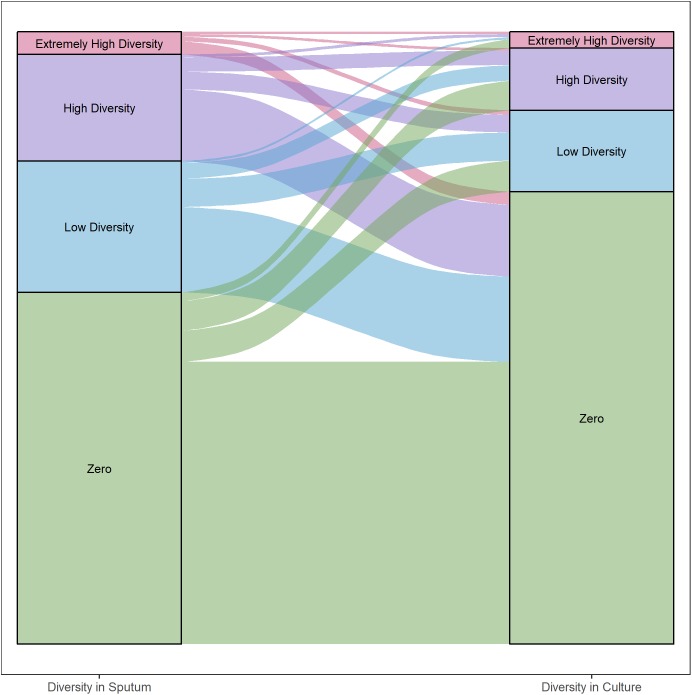
Differences in gene diversity of sputum and culture samples. Alluvial plot of changes in nucleotide diversity (π) per gene in sputum and culture samples (left and right, respectively). Inter- and intra-patient samples were all included. Categories defined by diversity quartiles: Extremely high (≥Q3 + 1.5 × IQR), high (≥Q2 and <Q3 + 1.5 × IQR), low (≥Q1 – 1.5 × IQR and <Q2) and zero diversity. Strata colored by each category. Strata width corresponds to the total number of genes in each category.